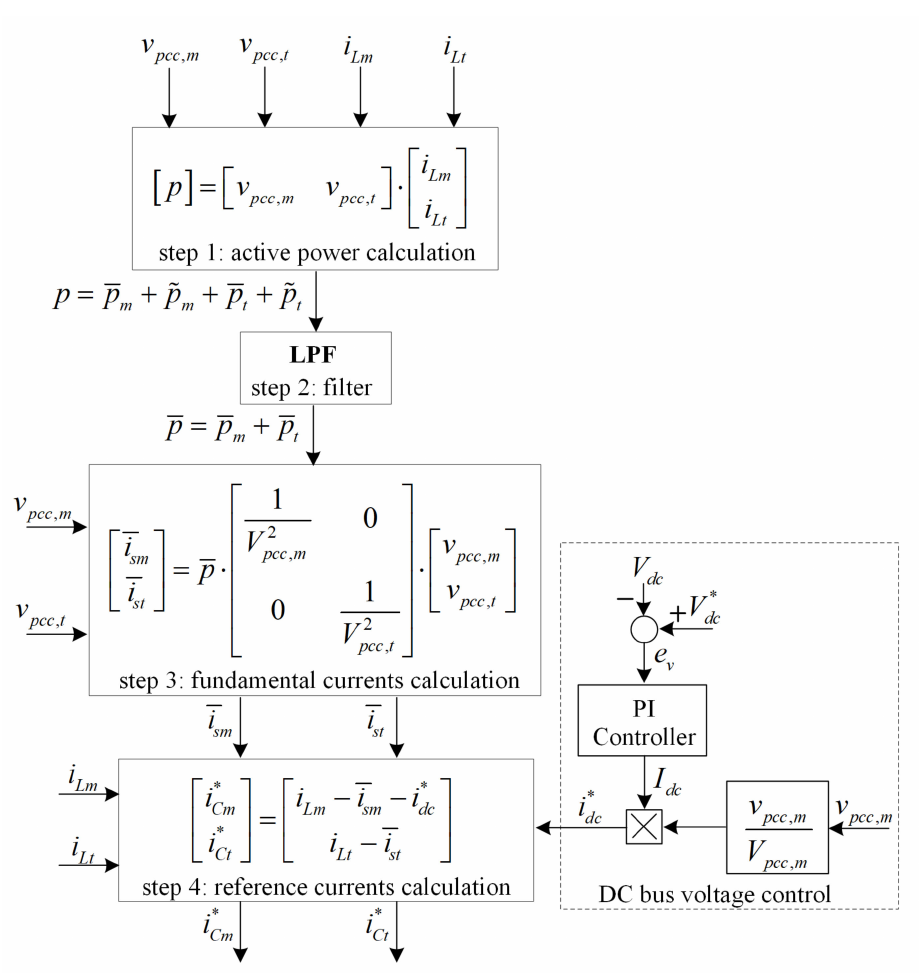
Figure 2. The block diagram of SD method for the APF in electric railway